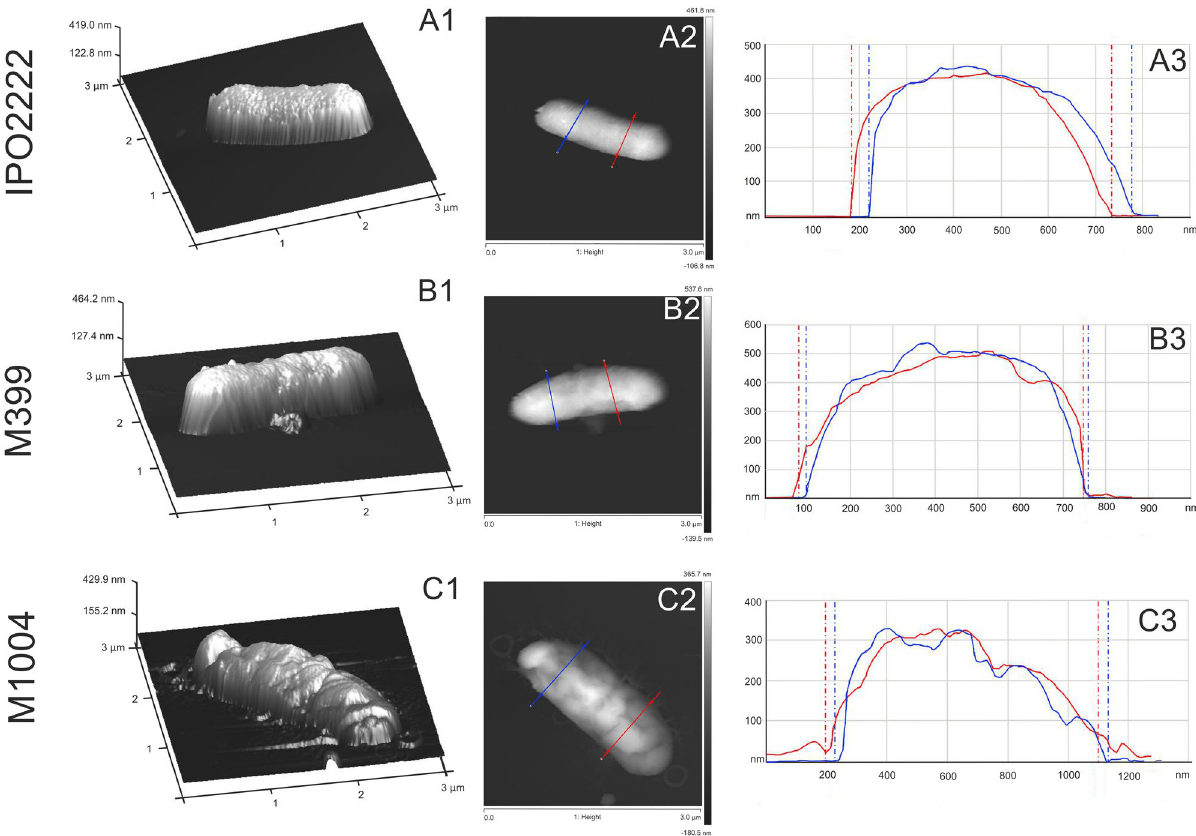
Figure 7. Atomic force microscopy (AFM) imaging of D. solani WT and selected phage-resistant mutants M399 and M1004. (panel A1–A3)—cell-surface D. solani IPO2222 WT; (panel B1–B3)—cell surface of phage- resistant mutant M399; (panel C1–C3)—cell surface of phage-resistant mutant M1004. (panel A1, B1, C1) –three-dimensional images of D. solani WT and mutant cells; (panel A2, B2, C2) –height mode images of cells; (panel A3, B3, C3)—height profiles of cells, the profiles were made along the lines shown in the height